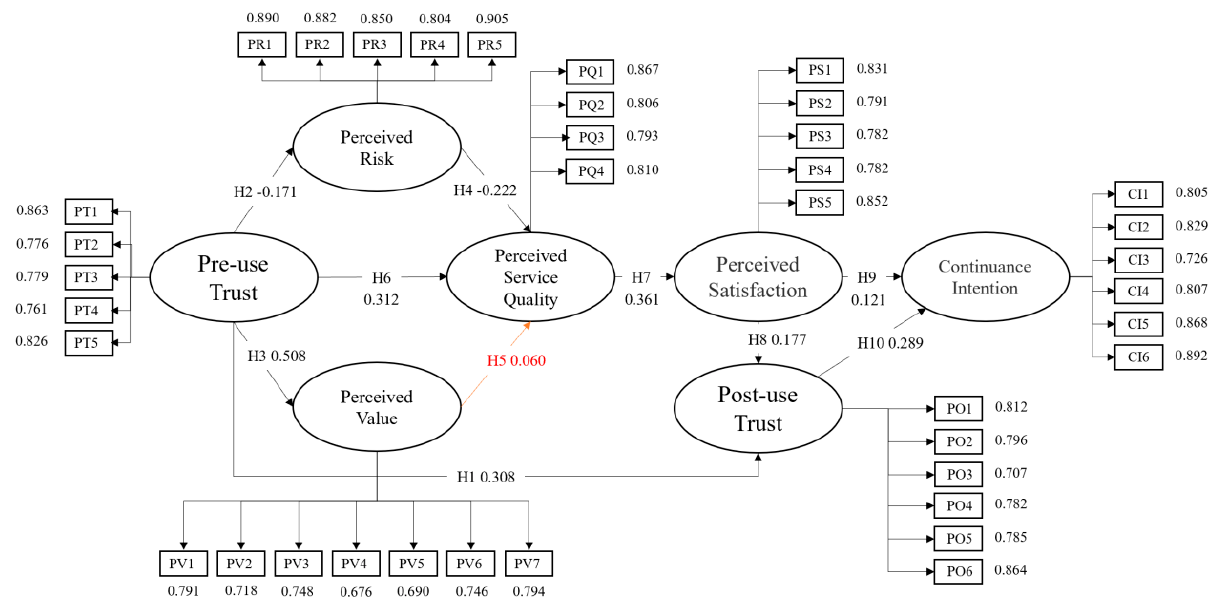
Figure 4. Research structure pattern diagram.